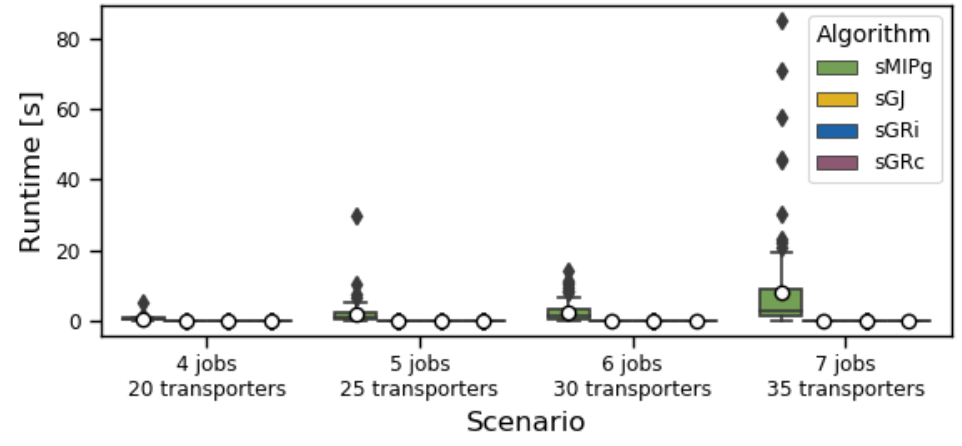
Figure 5. Distribution of running times of the algorithms, in seconds. The distributions are shown as box plots. The dot shows the average value and the line the median. The box (if it exists) shows the 25% to 75% quantile. If there is no box, then the values in those quantiles coincide with the average. Outliers are shown as diamonds.